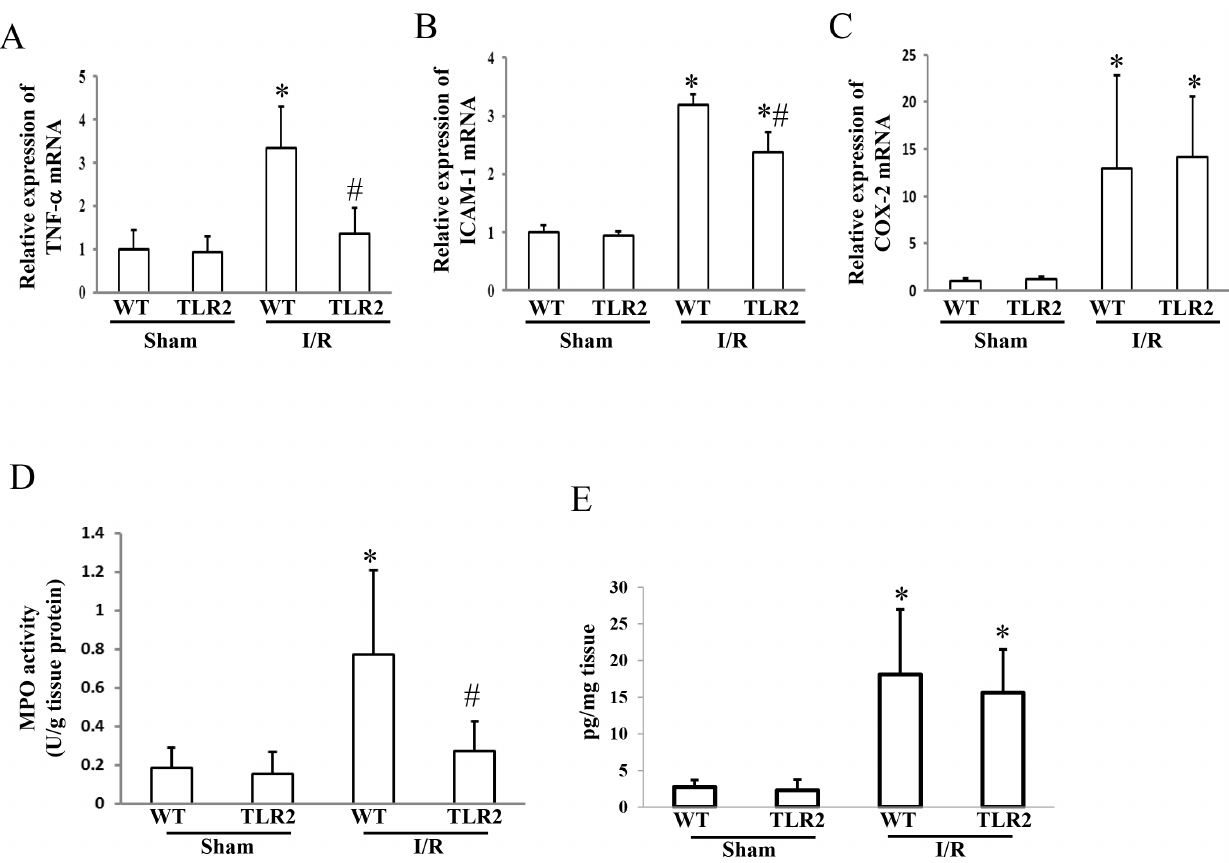
Figure 2. Effect of TLR2 deficiency on the expression of inflammatory mediators, neutrophil infiltration, and prostaglandin E 2 synthesis after the ischemia-reperfusion injury of the small intestine. Wild-type (WT) mice and TLR2 knockout mice were subjected to 45 min of ischemia, followed by 60 min of reperfusion. After removing the small intestine, the mRNA expression levels for the tumor necrosis factor (TNF)- a (A), the intercellular adhesion molecule (ICAM)-1 (B), and cyclooxygenase (COX)-2 (C) were determined. Assays were also performed to estimate the myeloperoxidase (MPO) activity (a marker of neutrophil infiltration, D), and the prostaglandin E 2 concentrations (E). Each column represents the mean 6 SD. N=6. * P , 0.01 vs WT mice with sham operation, # P , 0.01 vs WT mice subjected to the ischemia-reperfusion injury. I/R; ischemia/reperfusion